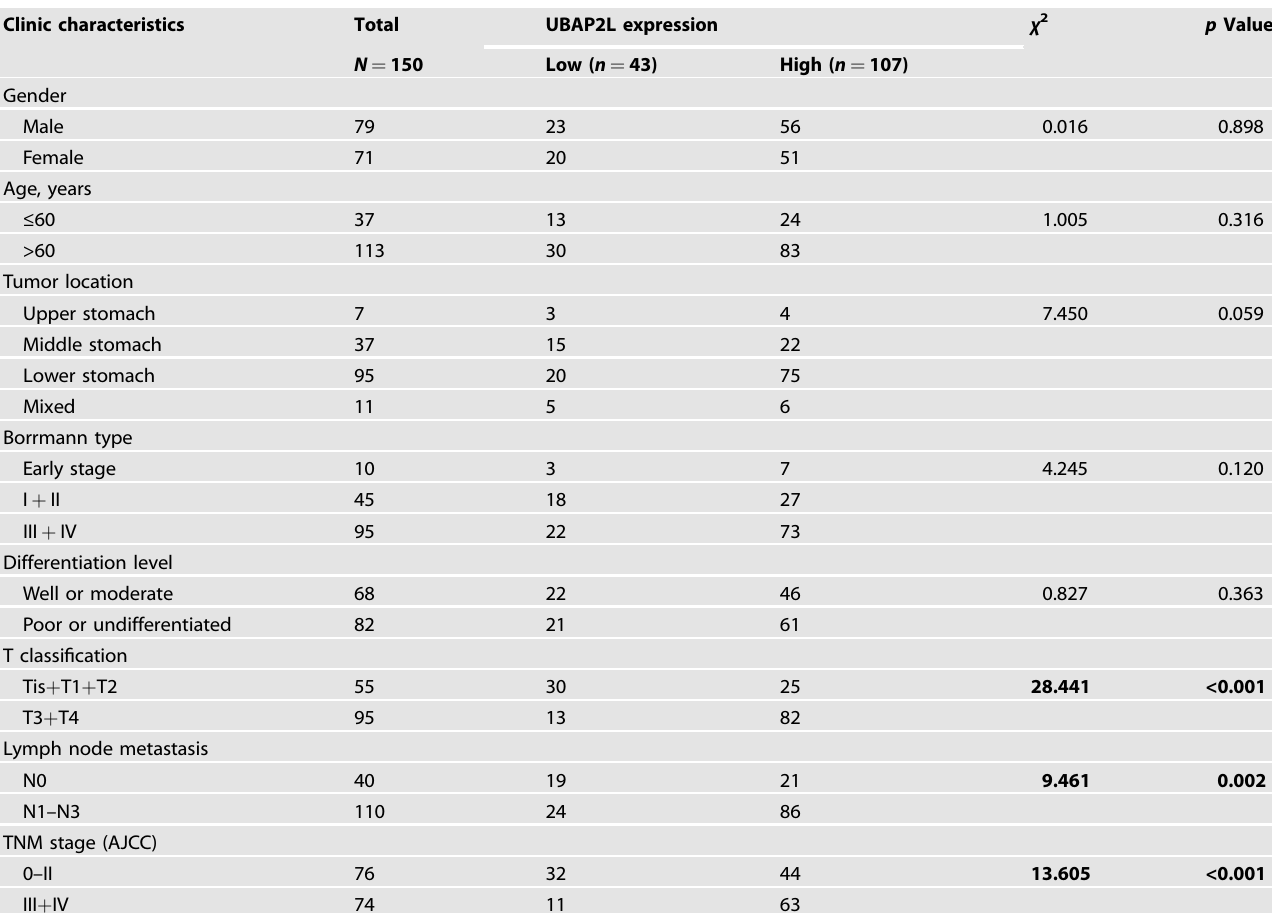
AJCC American Joint Committee on Cancer. Bold values indicate statistical